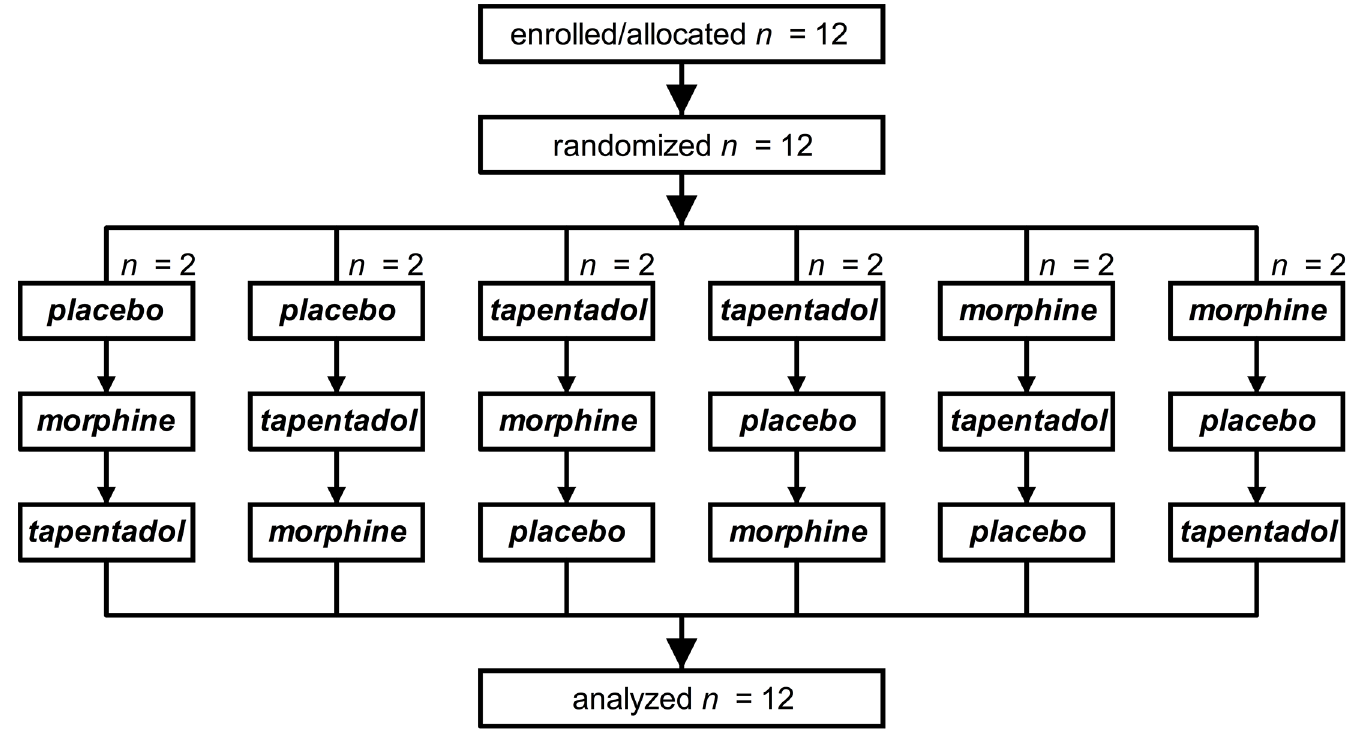
Fig 1. The setup used to induce Conditioned Pain Modulation (CPM). The volunteer sits on the bed while a thermal test stimulus is applied to the arm via a 3×3 cm thermode (insert top right). The leg is placed in a bucket filled with cold water ( ie . the conditioning stimulus) and the subject scores the heat pain to the arm using an electronic visual analogue scale (insert top middle). The cold water is applied via the Icydip system; the heat pain via Medoc ’ s pathway